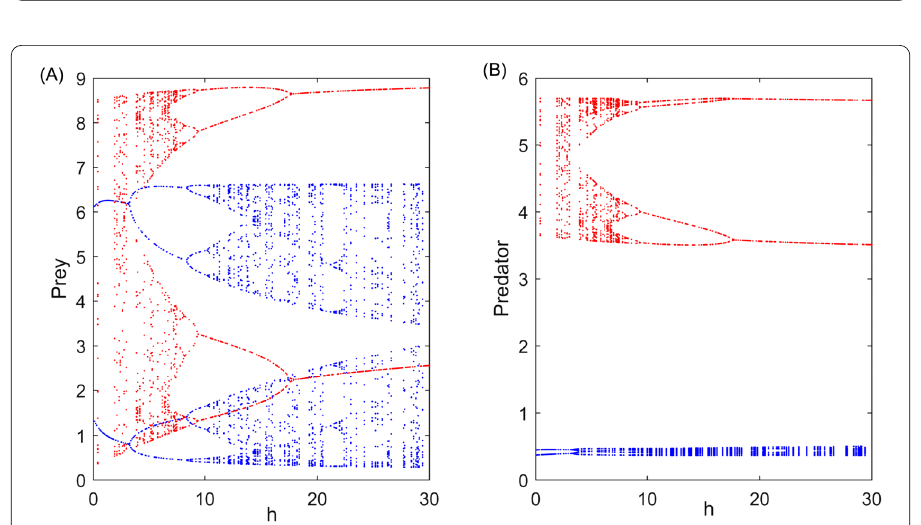
Figure 10 Bifurcation diagrams of model (17) with respect to bifurcation parameter h . Parameter values are: r = 2.26, k = 14, α = 1.2, c = 0.37, ω = 0.25, D = 0.59, δ = 0.31, λ 1 = 1.25, λ 2 = 5.2, θ = 1.65, T = 18. The red results are generated from initial values ( x 0 , y 0 ) = (2.5,2.7) and the blue results are generated from initial values ( x 0 , y 0 ) =